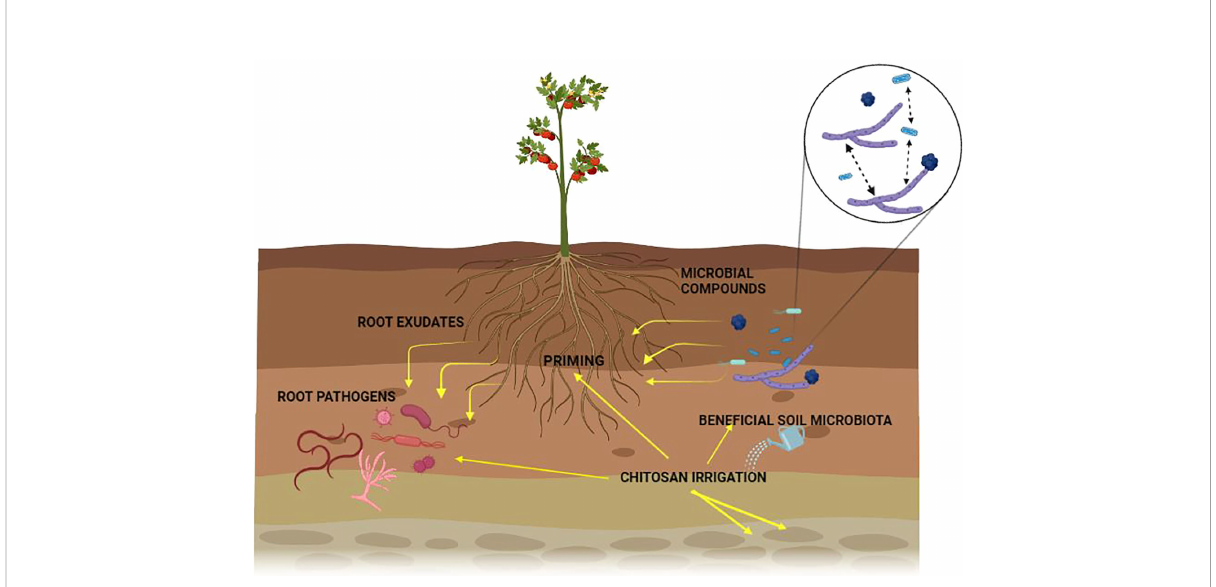
FIGURE 1 Effect of chitosan on plant-microorganism interactions in the rhizosphere.